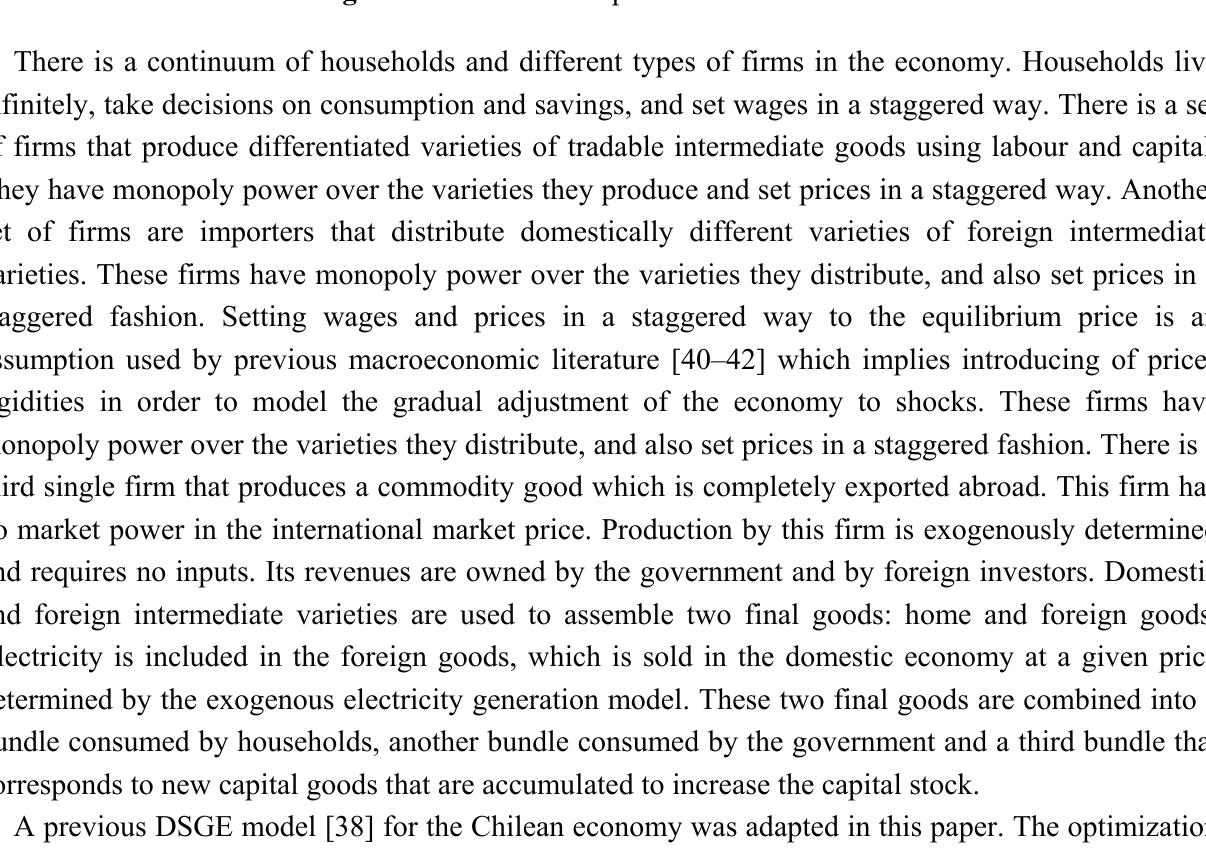
Figure 5. General description of DSGE